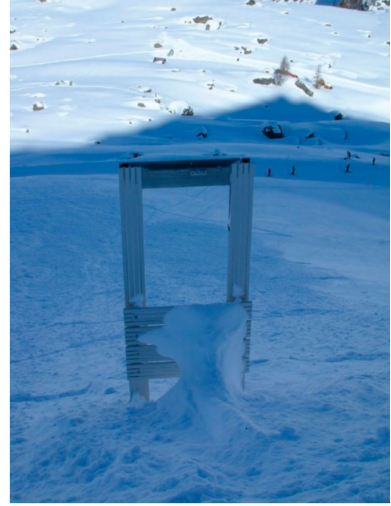
Figure 6. Obstacle after the events on 5 March 2011. Photo M.